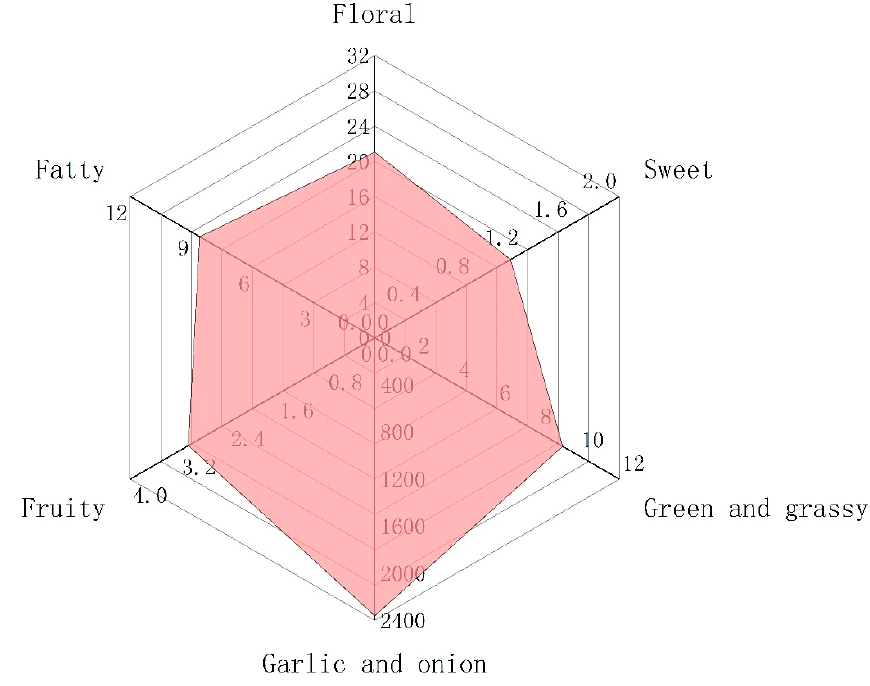
Figure 4 . The radar fingerprint chart of aroma composition of Chinese chive. Figure 4. The radar fingerprint chart of aroma composition of Chinese